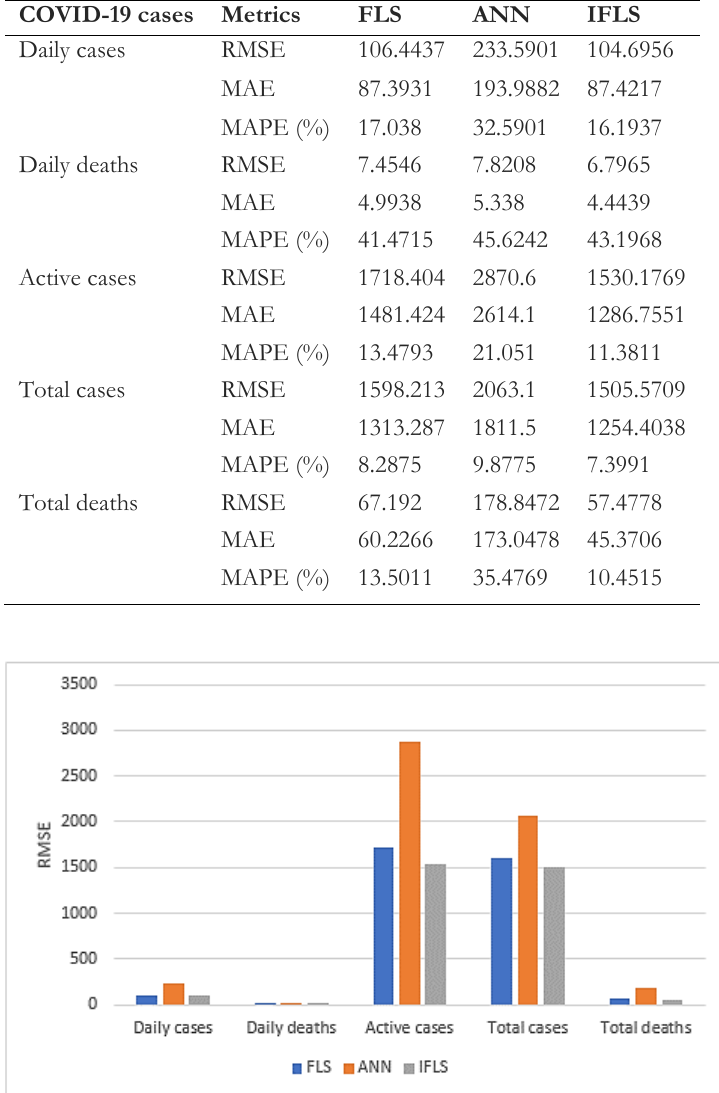
Table 7. Performance of FLS, IFLS and ANN on cases of COVID-19 based on different performance metrics.